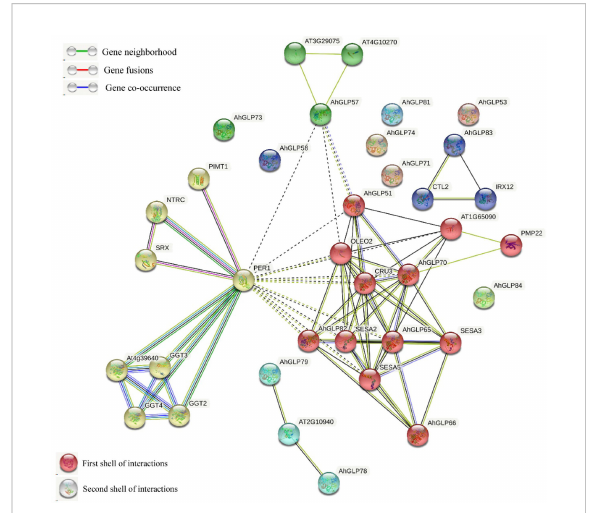
FIGURE 10 The predicted protein-protein interaction network of AhGLPs using the STRING database. Putative protein functions of AhGLPs are predicted on well-studied GLP orthologues in Arabidopsis